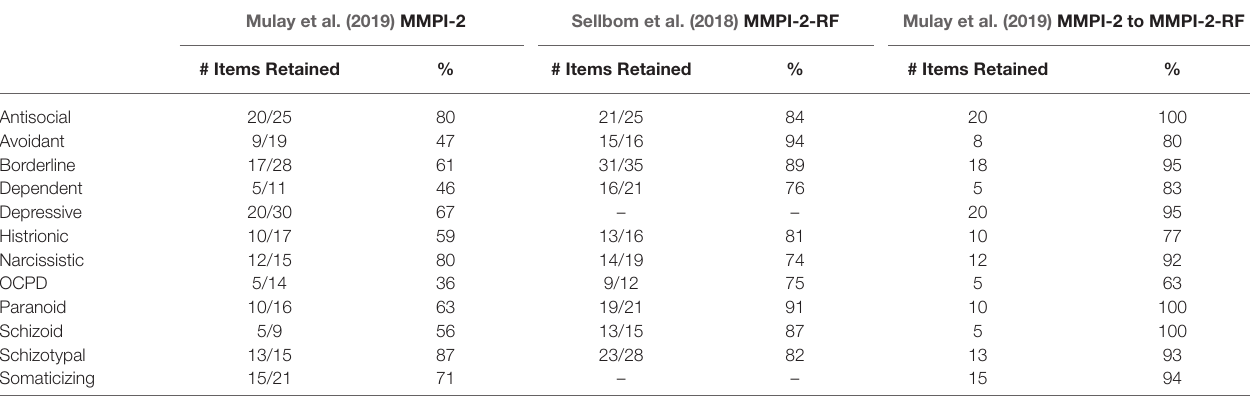
TABLE 4 | Personality Disorder Spectra Scales Items Carried on to the MMPI-3. Mulay et al. (2019) MMPI-2 Sellbom et al. (2018)